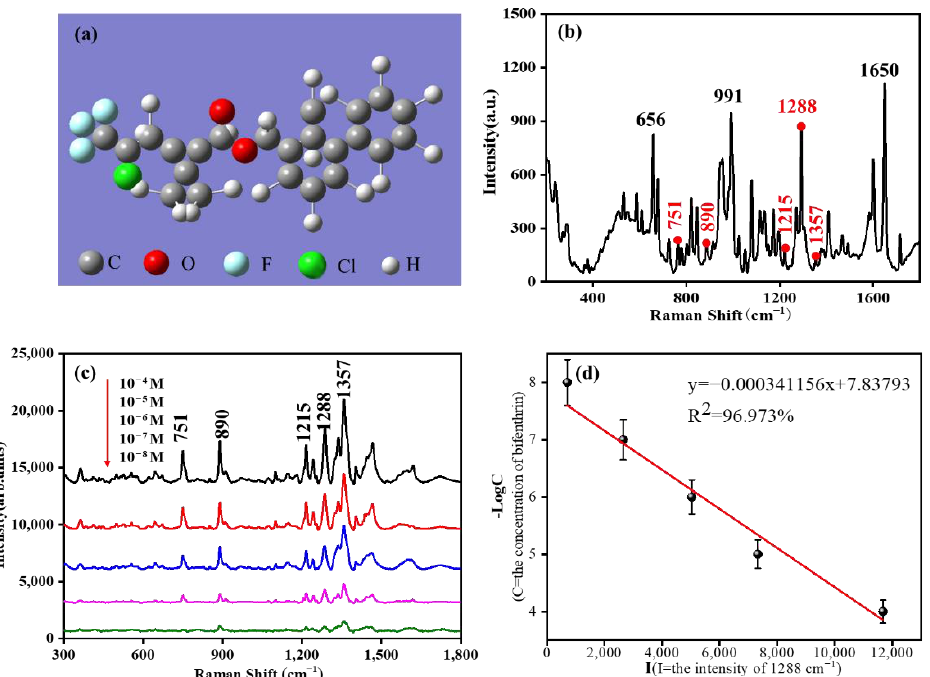
Figure 7. ( a ) The 3D molecular structure model of bifenthrin; ( b ) Bifenthrin solid-state Raman spectroscopy; ( c ) SERS spectra of different concentrations of bifenthrin detected by GO/Fe 3 O 4 @Au MNPs; ( d ) SERS peak strength linear fitting curve at 1288 cm −1 .